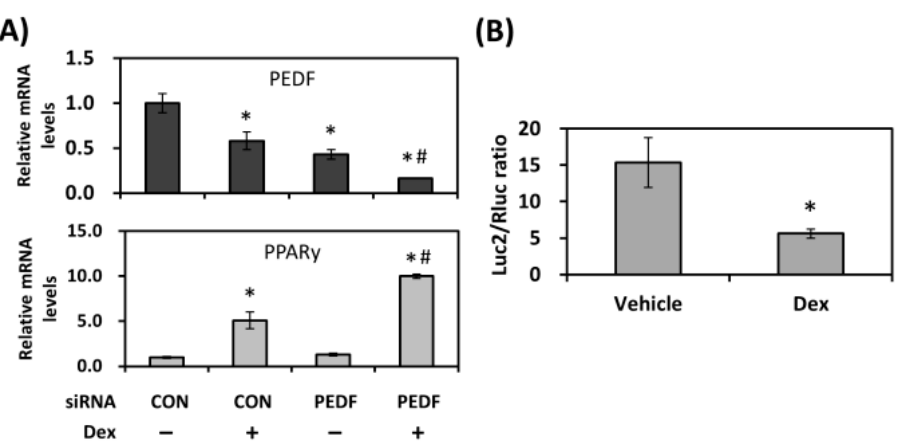
Figure 5. PEDF is down-regulated by dexamethasone during adipogenesis. ( A ) Rat AdSCs were transfected with control or PEDF siRNA, followed by incubation with dexamethasone (Dex) for six days. Gene expression was evaluated using quantitative RT-PCR. ( B ) Rat AdSCs were transfected with a PEDF reporter construct and treated with Dex for two days. Cells were then subjected to dual luciferase assays. Data are presented as relative mean ratios (firefly/Renilla luciferase units) ± SD. * Statistically significant from the controls at p < 0.05; # statistically significant compared with the PEDF siRNA transfected, vehicle-treated group at p < 0.05.